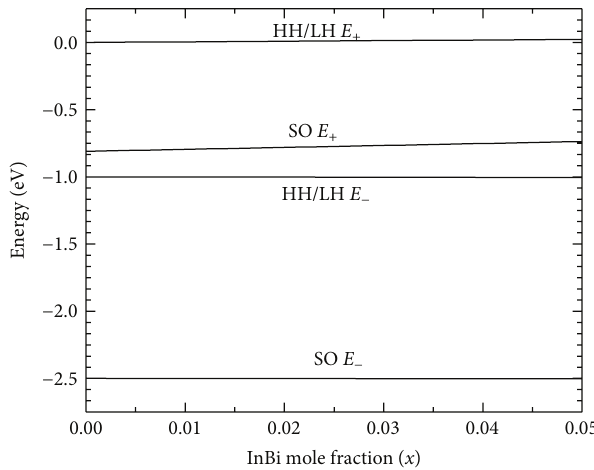
Figure 4: Calculated values of the 𝐸 + and 𝐸 − related heavy/light hole, and the spin-orbit split bands in InSb 1−𝑥 Bi 𝑥 , as a function of Bi mole fraction 𝑥